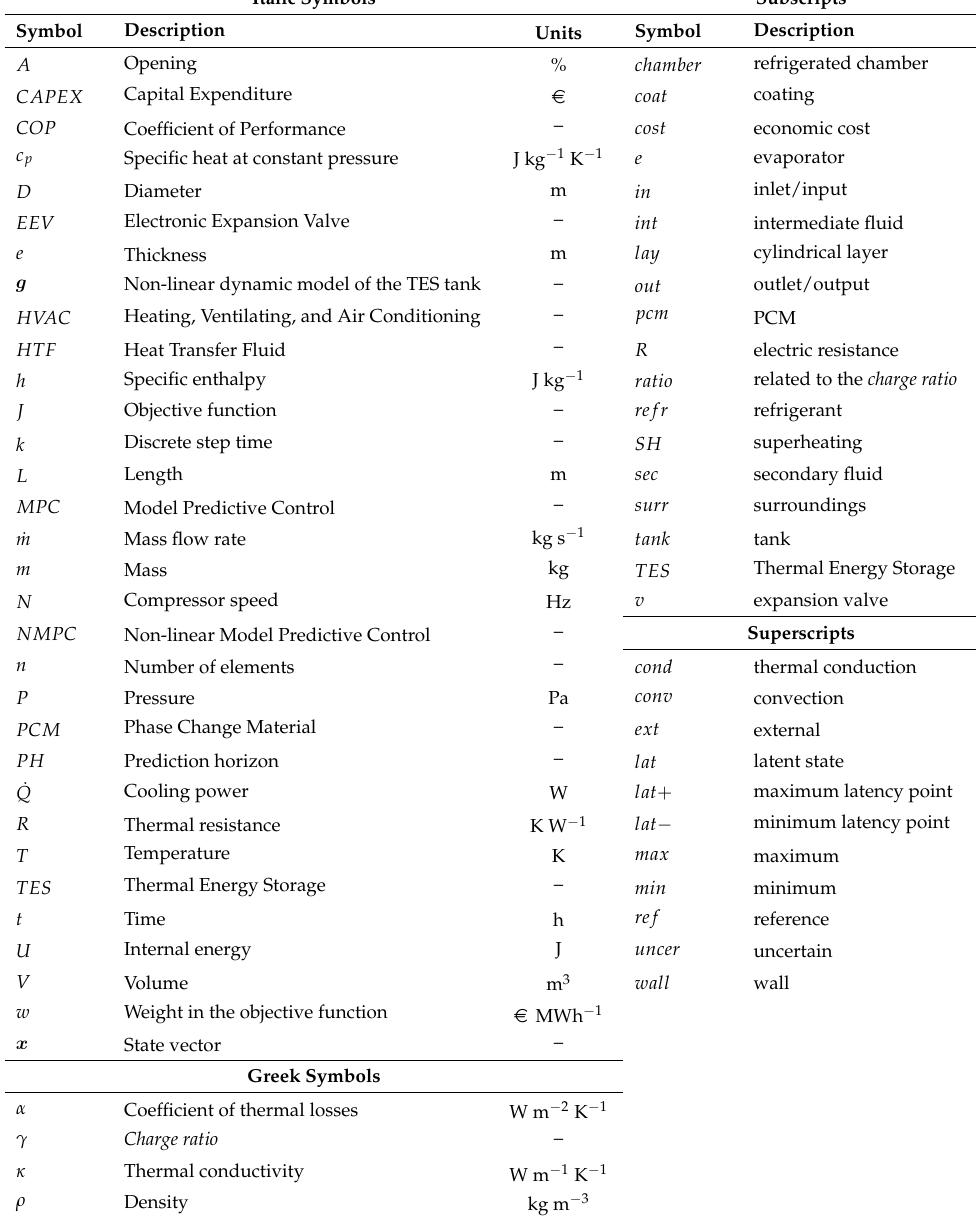
Table 1. Abbreviations, symbols, and subscript/superscript